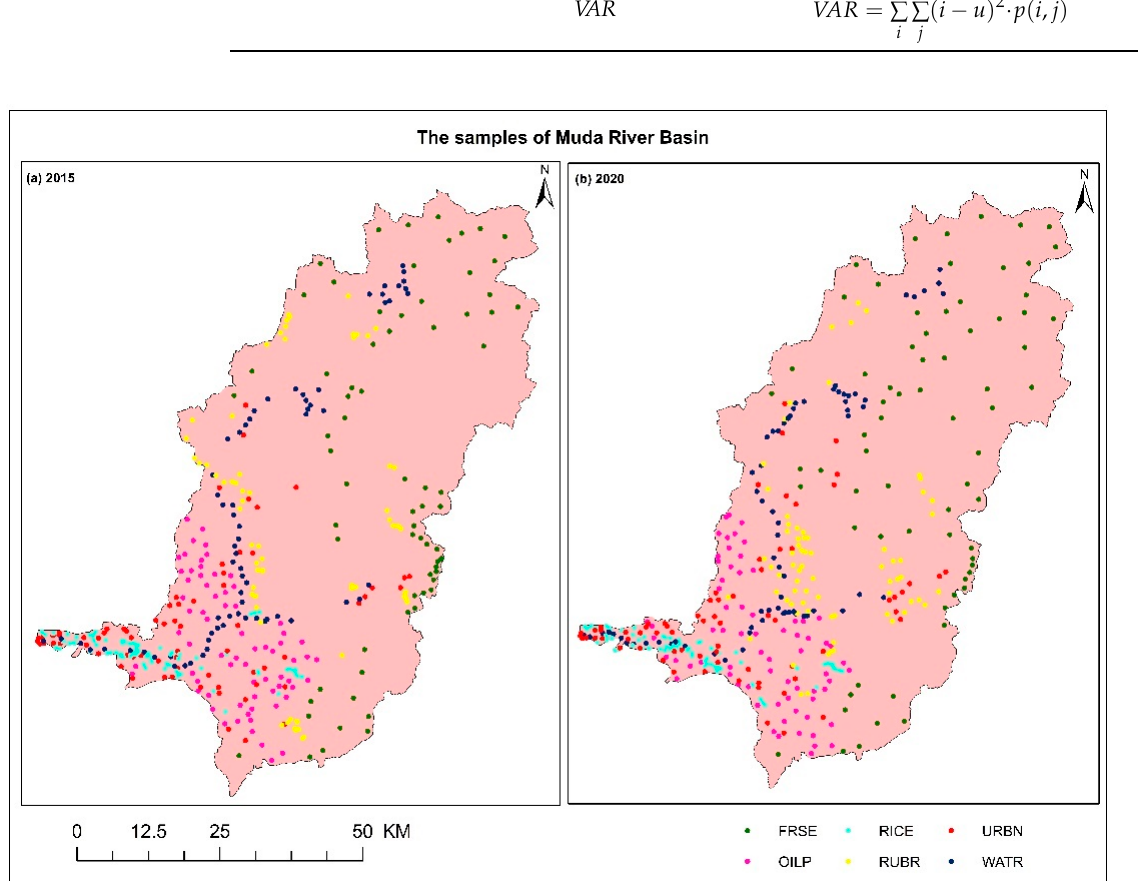
Figure 2. Samples of ( a ) 2015 and ( b ) 2020 collected from Google Earth Pro imagery and the field